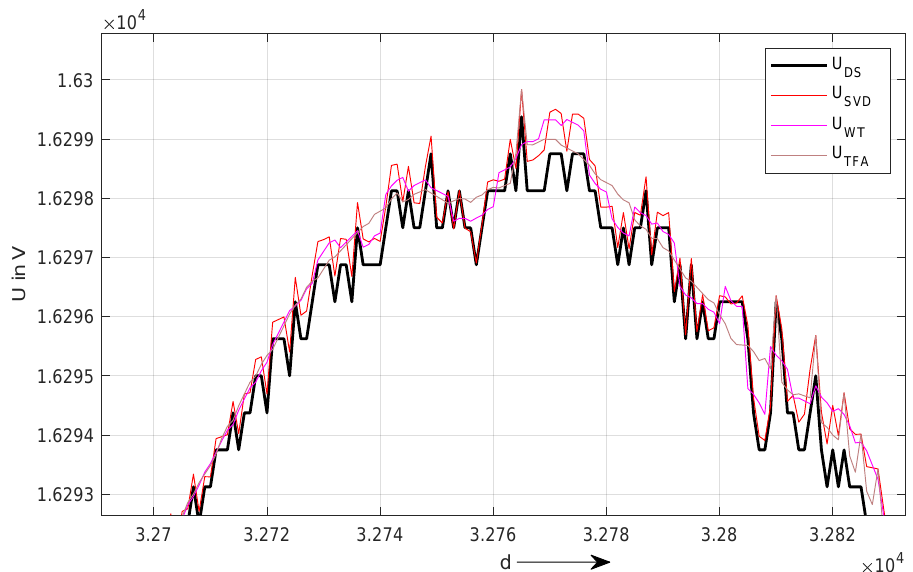
Figure 8. Comparison of U DS and the resulting compression outputs ∑ ( U base , U noise ( DC ) ) of the different lossy approaches.